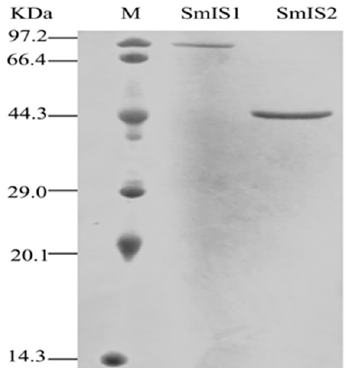
Figure 5. Heterologous expression of SmIS1 and Smis2 cDNA in E. coli . Lane SmIS1, purified recombinant SmIS1; lane SmIS2, purified recombinant SmIS2.